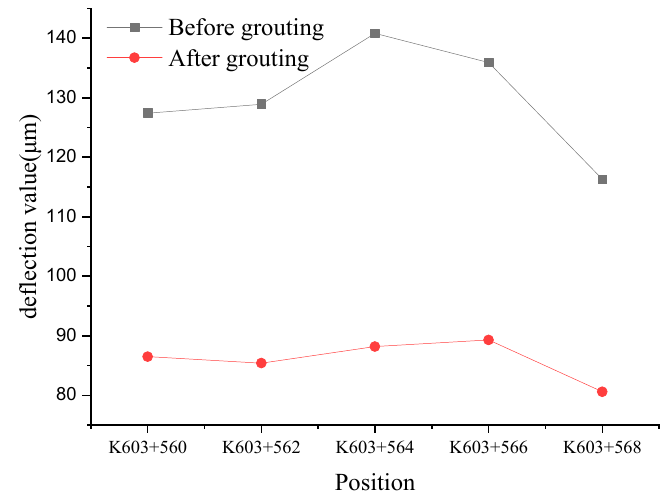
Figure 11. Deflection changes before and after